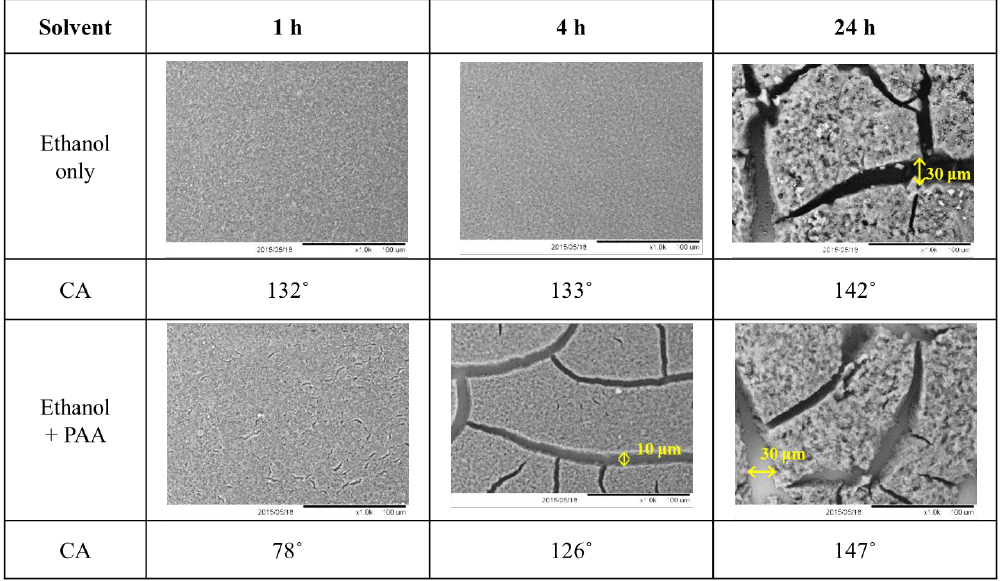
Figure 9. SEM images of the formed hydrophobic films with and without PAA. Coatings 2020 , 10 , x FOR PEER REVIEW